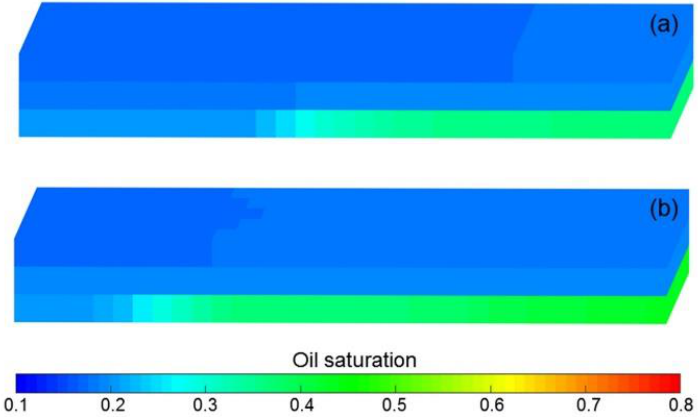
Figure 14. 3D remaining oil saturation distributions after polymer flooding of ( a ) Case 3 and ( b ) Case 5.